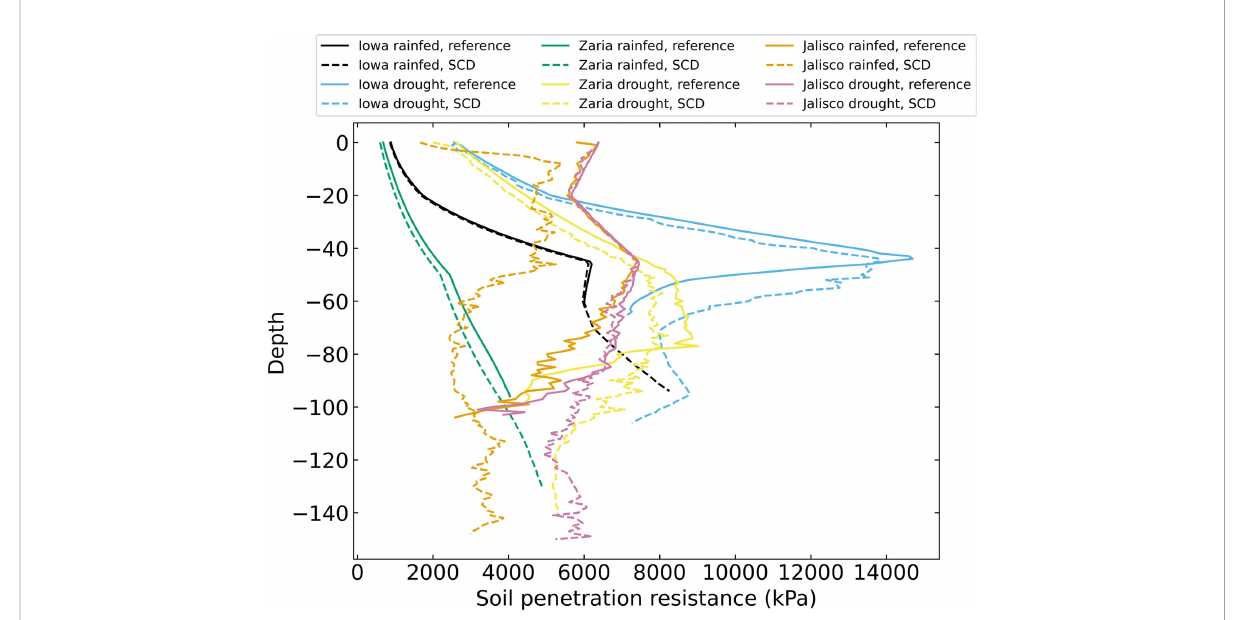
FIGURE 7 Soil penetration resistance felt by the roots on day 42 for 12 individual simulations, averaged over 1 cm